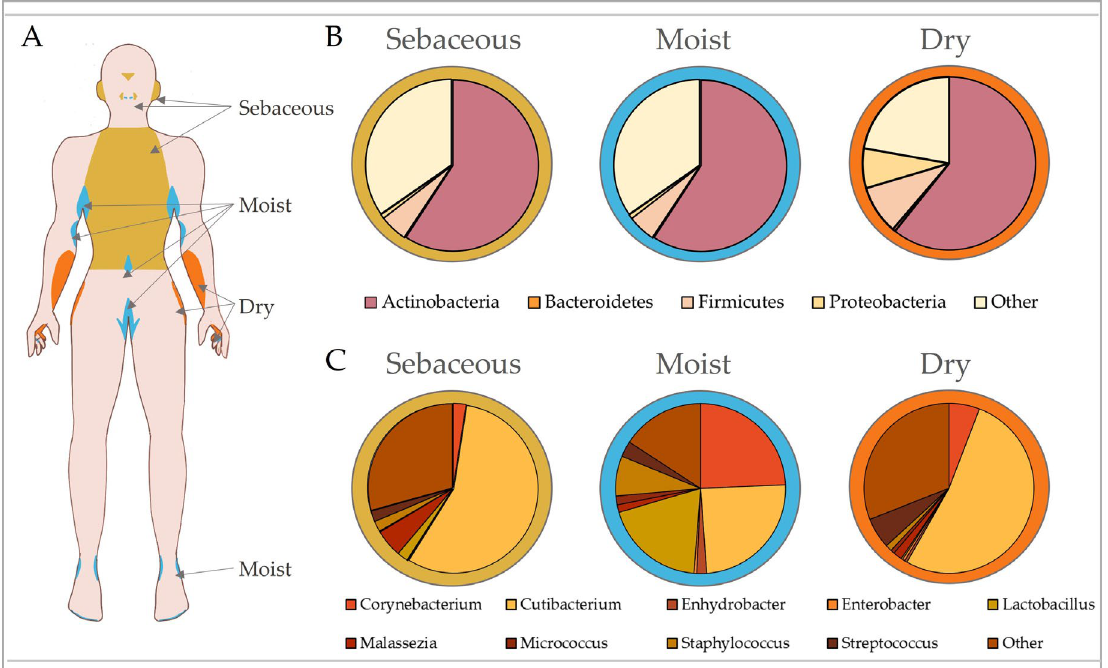
Figure 2. Microbial composition of the skin is dictated by topography. Skin exhibits biogeographically distinct regions that are generally categorised according to their unique physiological characteristics into sebaceous, moist and dry sites ( A ). These regions exhibit different microbial community structures influenced by skin pH, temperature, sebum content and moisture levels. Microbiota are separated by phylum according to site-specific variation in ( B ), with top contributing genera shown in ( C ). In healthy adults, sebaceous (e.g., torso, glabella and retroauricular crease) and dry (e.g., volar forearm and hypothenar palm) sites are predominantly colonised by Cutibacterium , while moist sites (e.g., antecubital fossa, inguinal crease and axillary crease) show equally high abundances